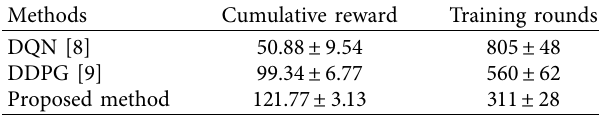
Table 1: Algorithm parameters.